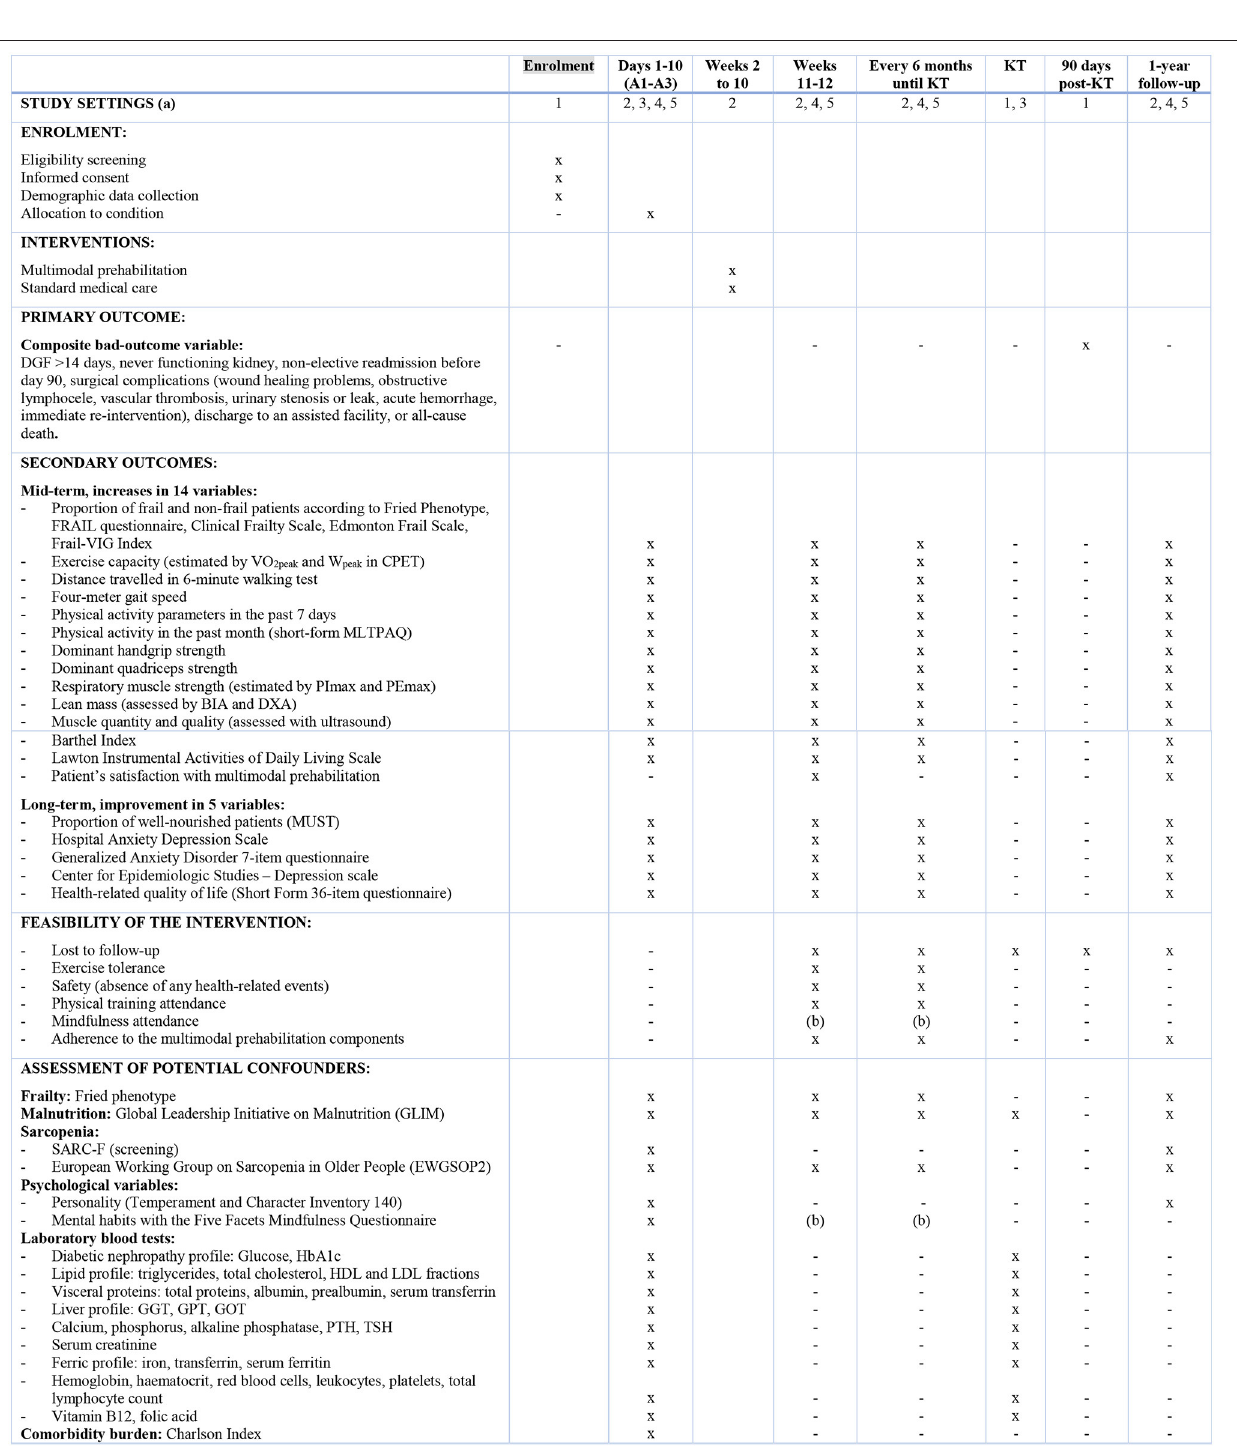
Frontiers in Medicine |